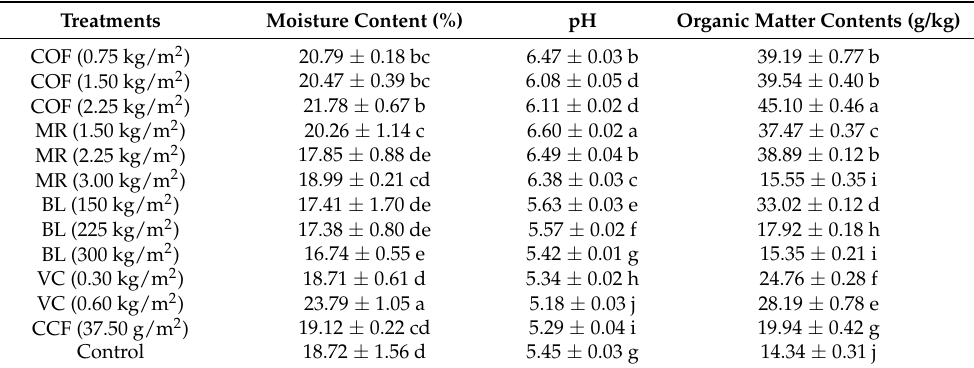
Table 2. Effect of different biological organic and chemical fertilizer on the pH, content of moisture, and organic matter in new reclamation